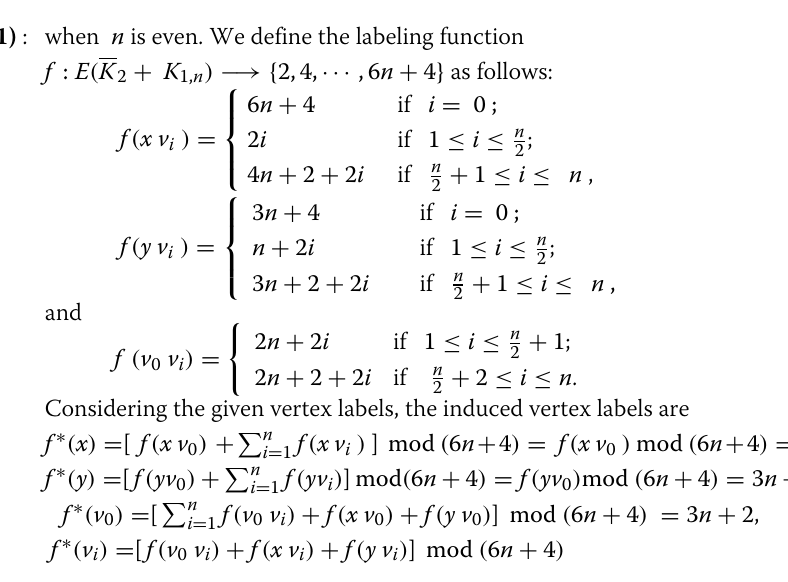
Illustration: In Fig. 5, we present an edge even graceful labeling of the graph K 1 + sf 8 . Edge even graceful labeling of the join graph K 2 + K